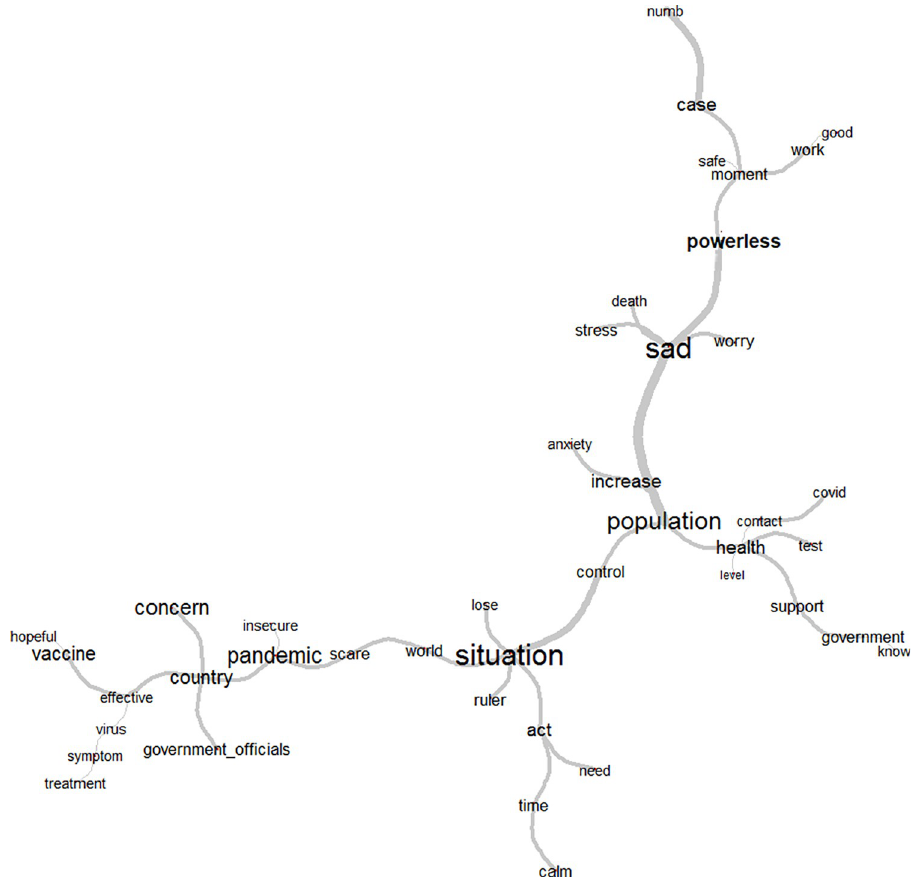
Fig 5. Similarity tree for Class 3: feeling of powerlessness and need for government policies and action. Source: COVIDPRO Project (2020). Rio de Janeiro–Brazil, 2020. (N = 554).